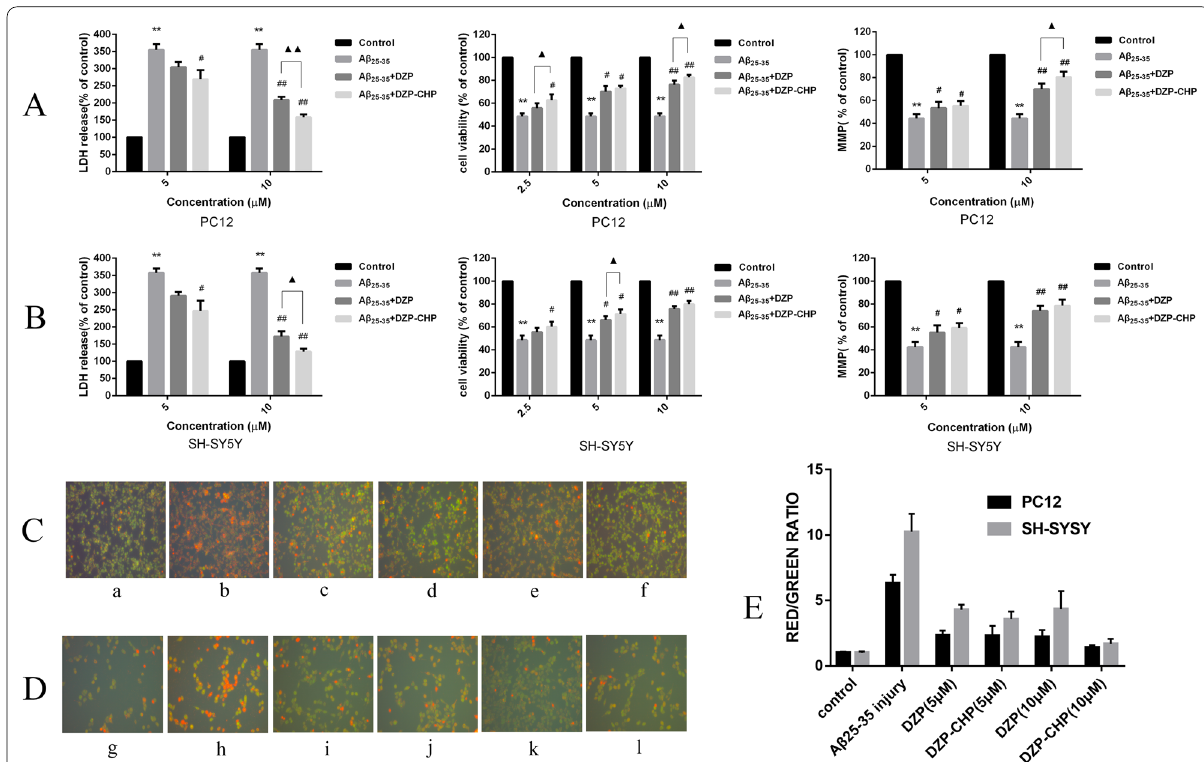
Fig. 9 Effect of DZP-CHP on Aβ25-35-injured PC12 and SH-SY5Y cells. a and b The effects of DZP-CHP on the cell survival rate, LDH activity, and mitochondrial membrane potential of PC12 and SH-SY5Y cells injured by Aβ25-35 (# P < 0.05, ## P < 0.01 vs Aβ25-35 group; ▲ P < 0.05 vs DZP group). c The effect of DZP-CHP on the apoptosis morphology of PC12 cells injured by Aβ25-35; a—control group, b—Aβ25-35 injury group, c— DZP (5 µM), d—DZP -CHP (5 µM), e—DZP (10 µM), f—DZP-CHP (10 µM). D: the effect of DZP-CHP on the apoptosis morphology of SH-SY5Y cells